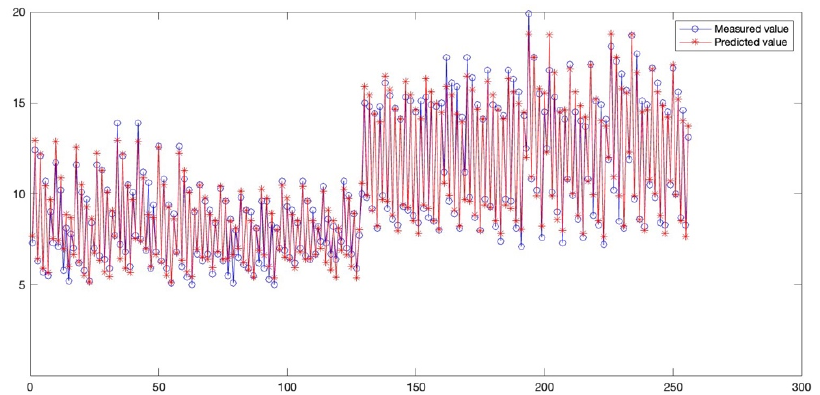
Figure 9. The comparison between the actual value of the bond strength of the plywood and the predicted value of the CPA-BP model is shown in Figure 9.